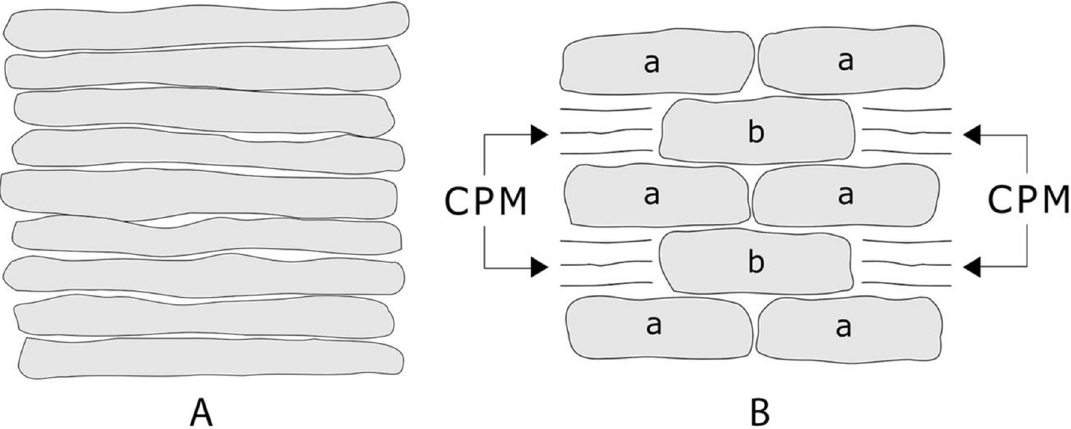
Fig 1. Examples are stacked plate masonry (A) and stacked core masonry (B). Stones marked (a) in example (B) would correspond to "headers" in contemporary brick masonry. Stones marked (b) in example (B) would correspond to "stretchers" in modern brick masonry and core stones in Ancestral Puebloan masonry. CPM (core protection masonry) in Ancestral Puebloan masonry consists of slabs wedged between courses of stones (a) to provide levelness and to protect the mud mortar.